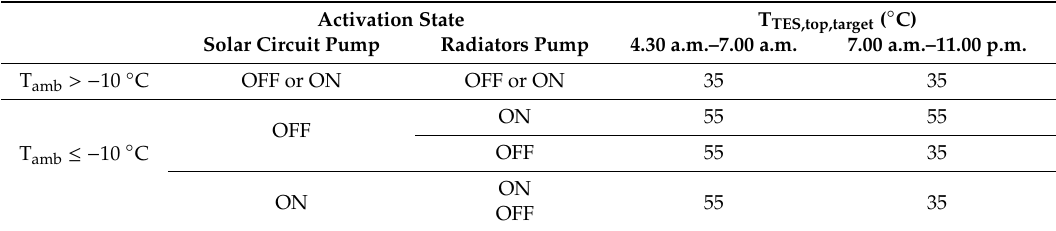
Table 6. Set-point temperature at the top of the thermal energy storage for the operation of the proposed